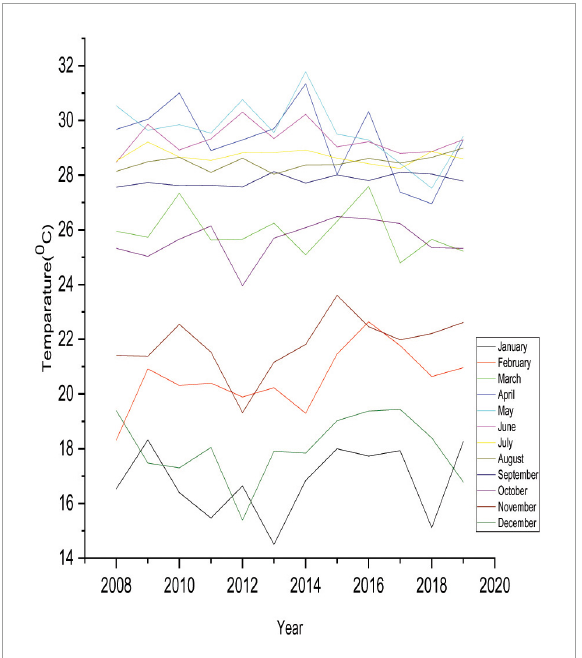
FIGURE3 Monthly historical temperature pattern.